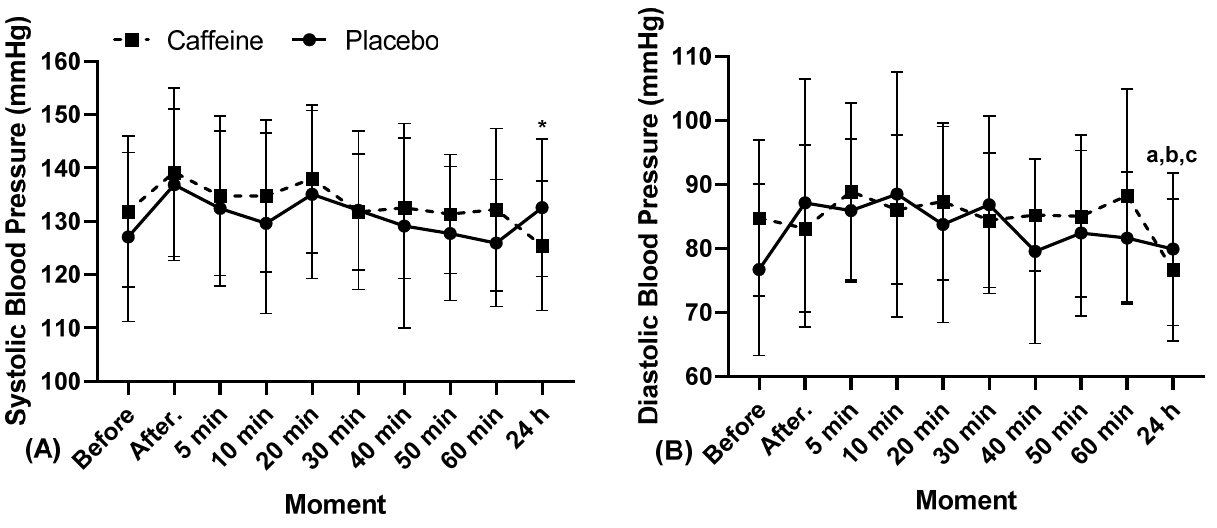
Figure 2. Cardiovascular response after resistance exercise with caffeine and placebo in relation to ( A ) Systolic Blood Pressure, ( B ) Diastolic Blood Pressure, min: Minutes, h: Hours. “*” indicate interclass, and “a”, “b”, and “c” indicate the intraclass difference.